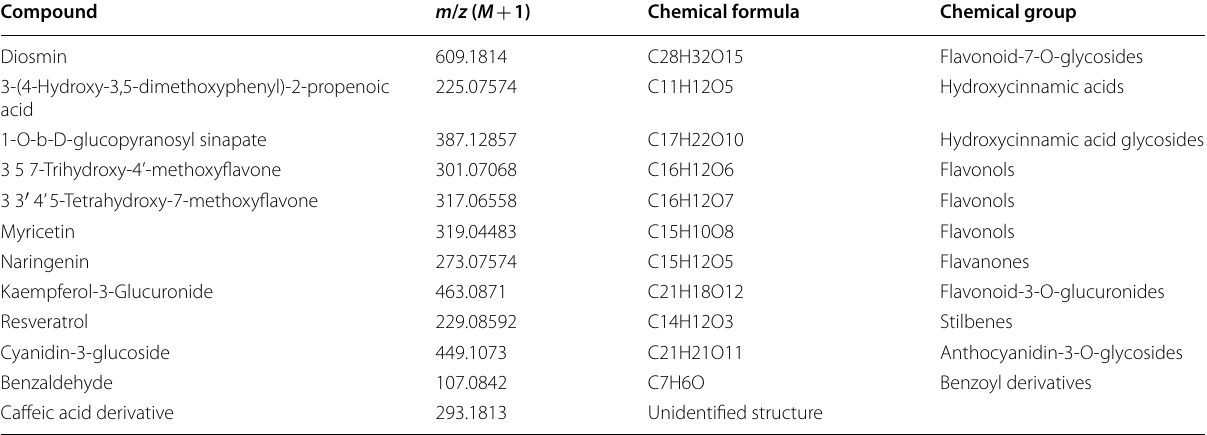
Table 4 UPLC-ESI-TOF–MS identified compounds of Enhalus acoroides (L.f.) Royle leaves